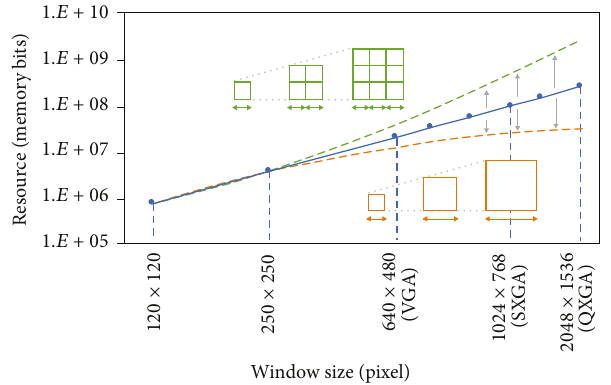
Figure 7: Window size and hardware resource scaling (log-log